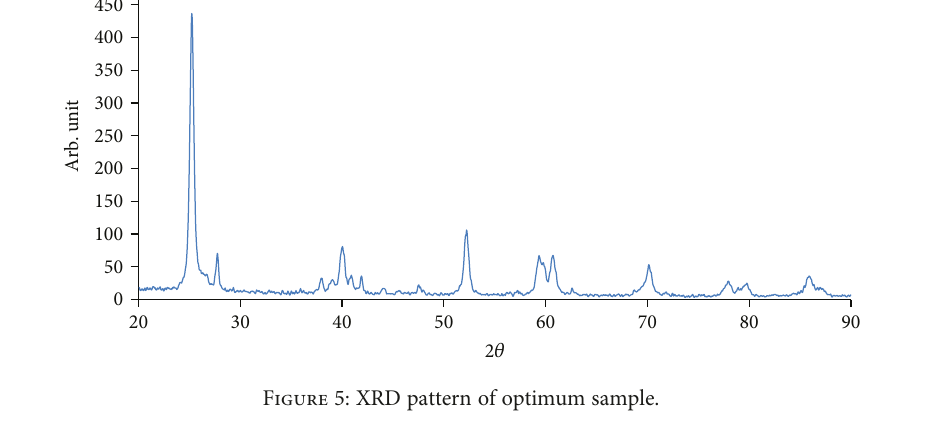
Figure 5: XRD pattern of optimum sample.